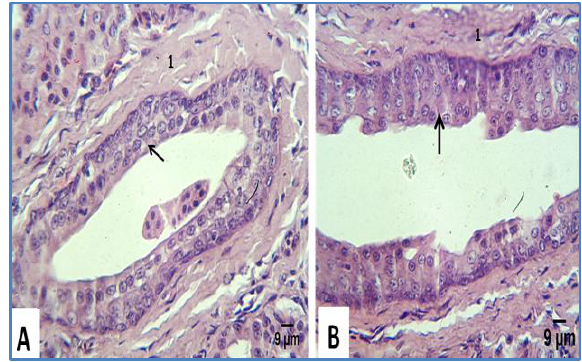
Figure, 9: Flamingo's salt gland. Micrograph (A): Transverse section of central ducts shows: double layer of cuboidal cells (Black arrows), tubular part of secretory units (Red arrows), and collagenous connective tissue (1). Micrograph (B): Transverse section of the main duct shows: stratified cuboidal epithelium (black arrow) and collagenous connective tissue (1). (H and E) stain.